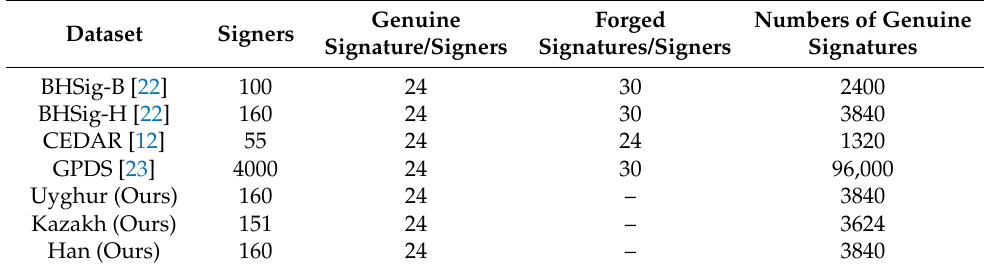
Table 1. Comparison of data volumes for different data sets.